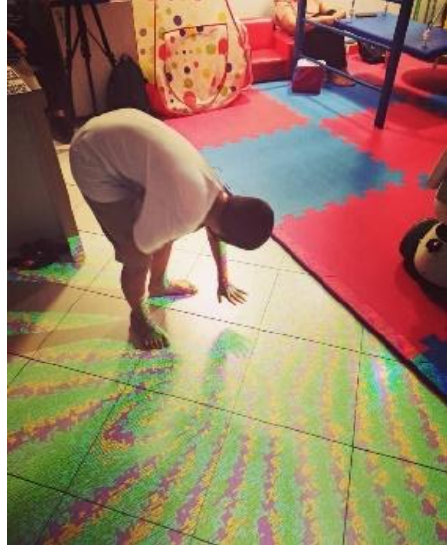
Figure 6. Interface of the game “Music